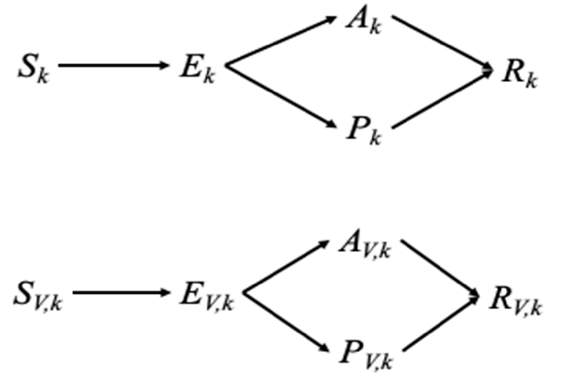
Figure 1. Movement of individuals between disease and vaccination status.